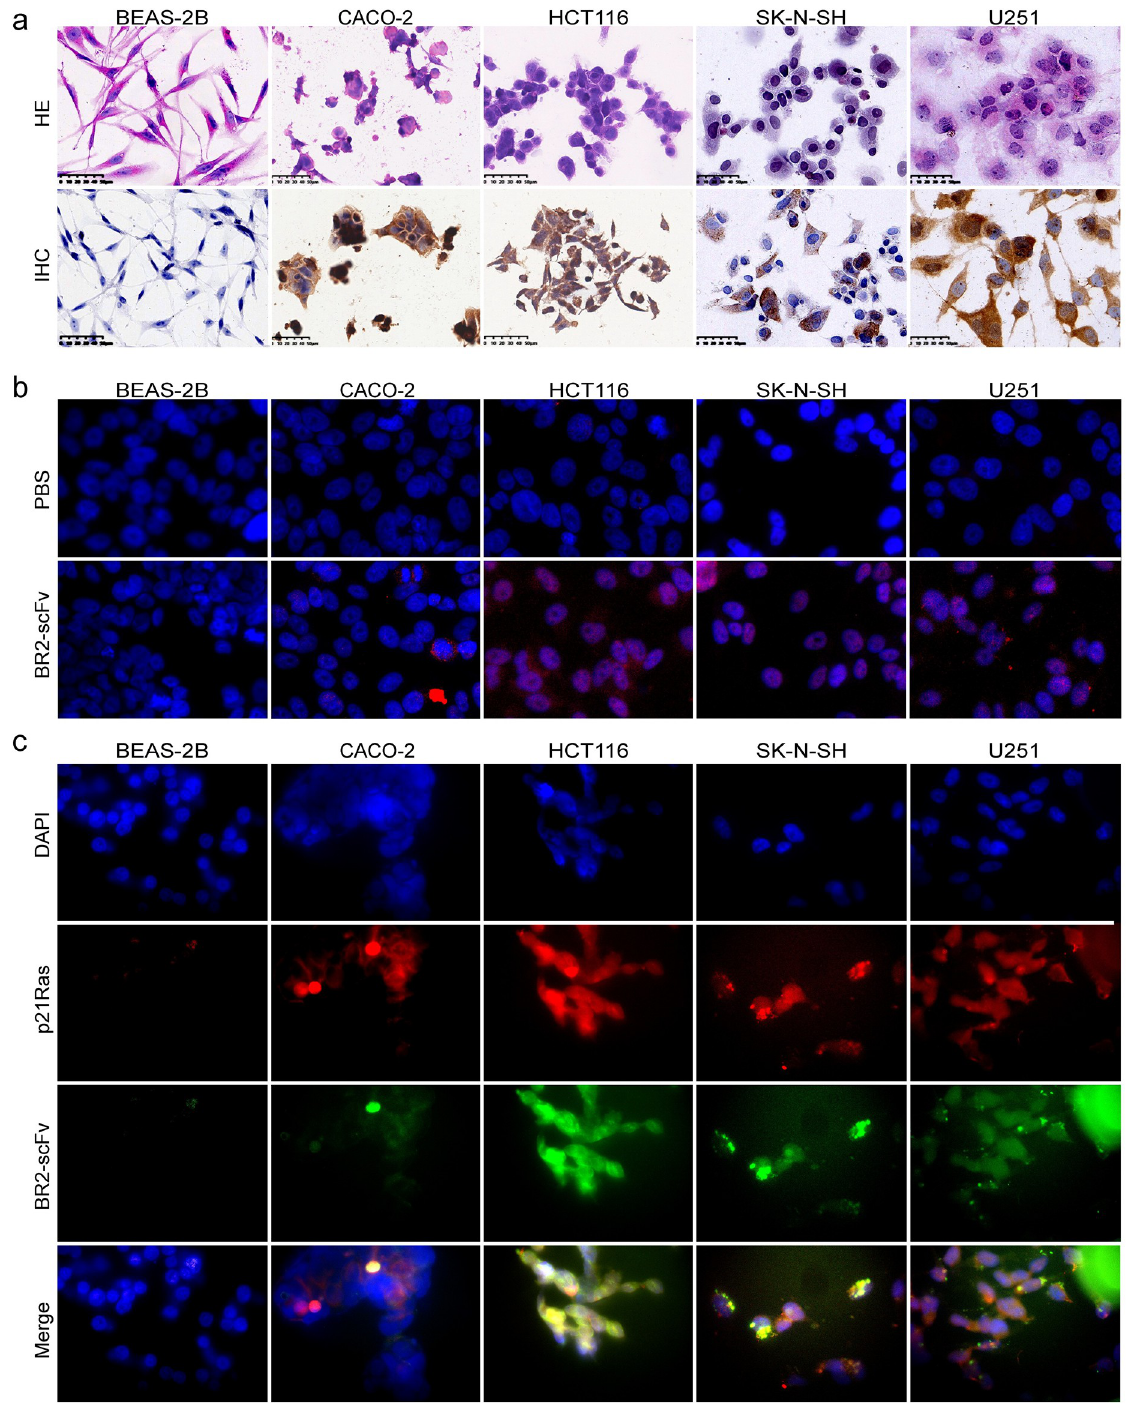
Fig 2. BR2-p21Ras scFv(BR2-scFv) could enter GS expressing tumor cells and bind to p21Ras. ( a ) HE staining of cell climbing sheets showed that normal cells BEAS-2B were long spindle shaped and had benign characteristics, including single existence, consistent size and shape, oval nucleus and no atypia. Tumor cells HCT116, SK-N-SH, U251 and CACO-2 have obvious atypia, including mass growth, different size and morphology, increased nuclear to cytoplasmic ratio, large and deep staining of nuclei, and irregular nuclear morphology. Immunohistochemistry (IHC) demonstrated that that normal cell BEAS-2B did not express Ganglioside(GS), and tumor cells HCT116, SK-N-SH, U251 and CACO-2 expressed GS in cytoplasm and membrane (yellow). ( b ) After co-culture with BR2-scFv, BR2-scFv was detected by immunofluorescence microscopy in HCT116, SK-N-SH, U251 and CACO-2 cells, but none was detected in BEAS-2B cells. Red: